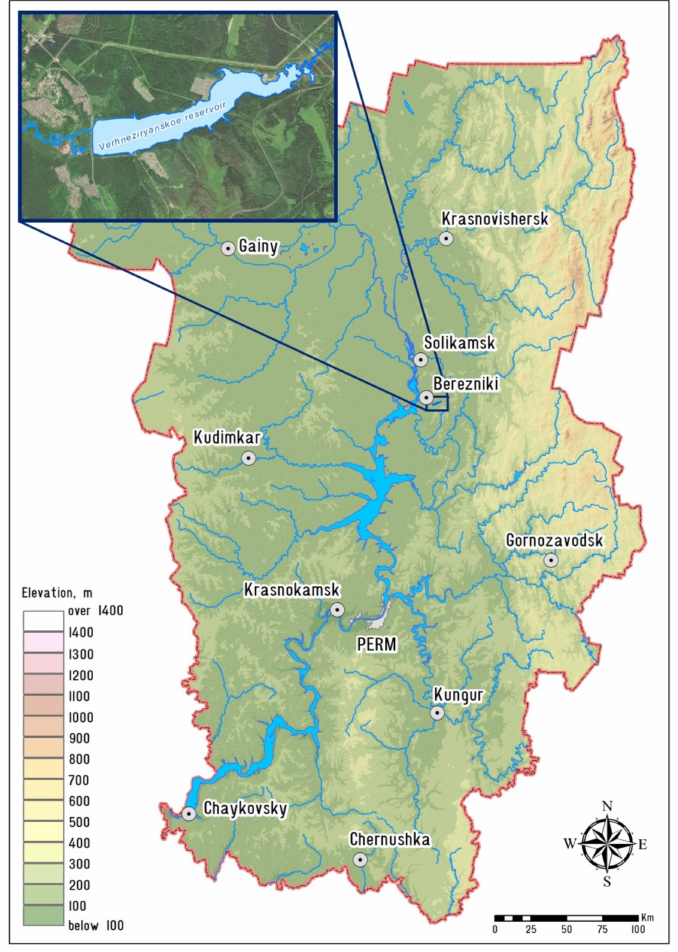
Figure 1. Overview map of the Verhneziryanskoe reservoir